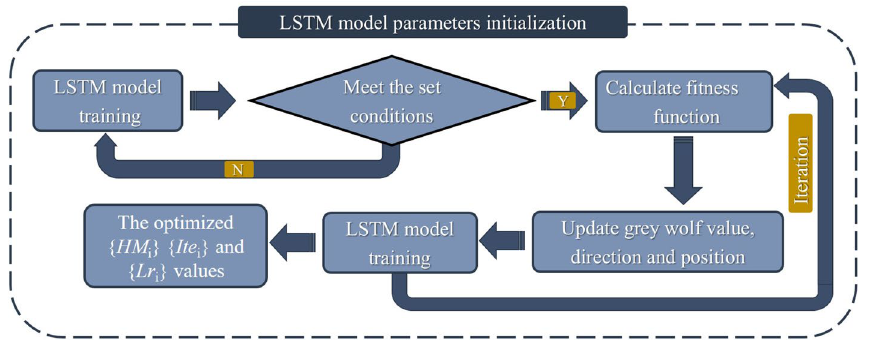
Figure 11. Analysis flowchart of the GWO-LSTM prediction